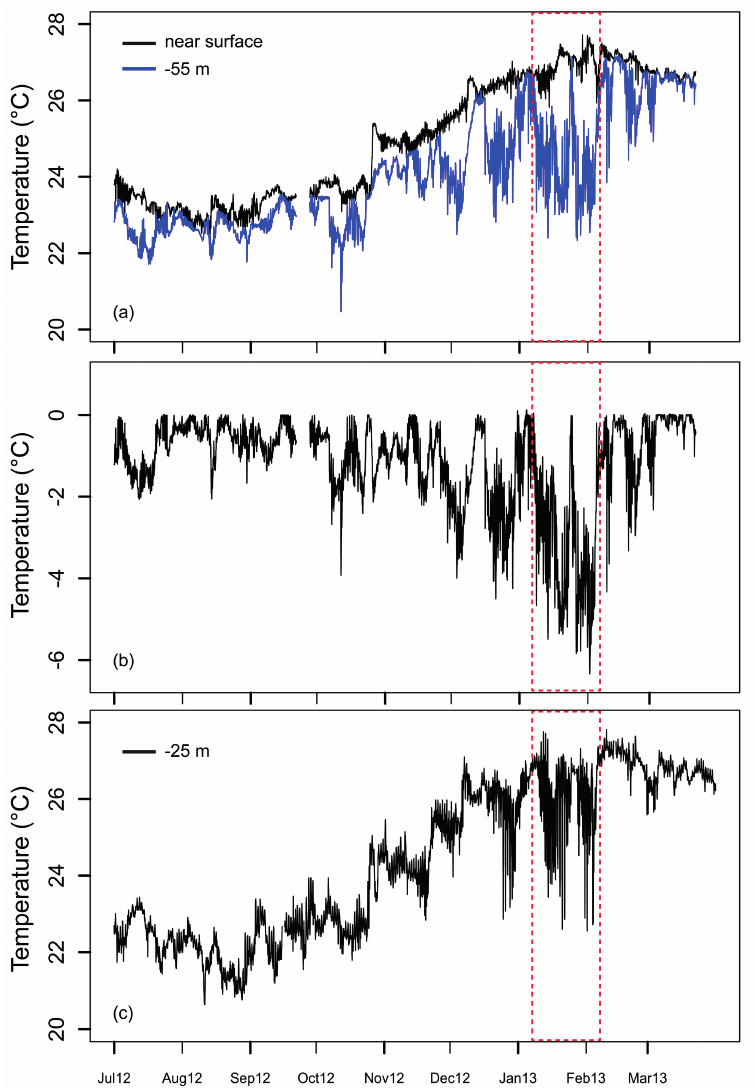
Figure 5. Plots of temperature data from July 2012 to March 2013. ( a ) Concurrent temperature traces from loggers near surface (9 m depth) and near bottom (55 m depth) on an in-line mooring located east of One Tree Island (OTE); ( b ) Upwelling index (temperature difference between 9 m and 55 m depths) for the OTE data; ( c ) Temperature trace from a logger located near bottom (20.5 m depth) on ‘Spiders Ledge’ at Lady Elliot Island. The period from 10 January to 5 February is highlighted by dashed red